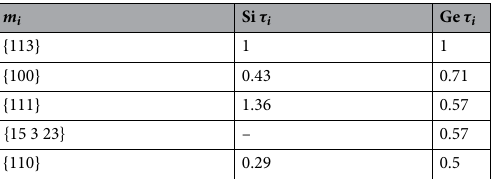
Table 1. Incorporation parameters